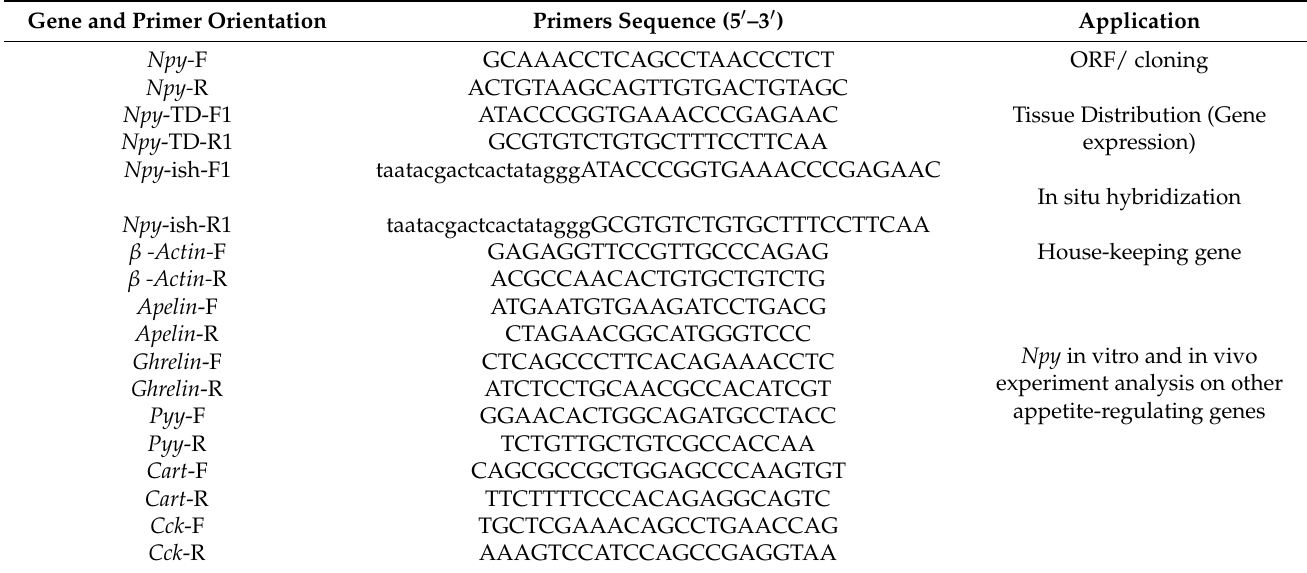
Table 1. Genes and primer sequences used for cloning, tissue distribution, and in situ hybridization